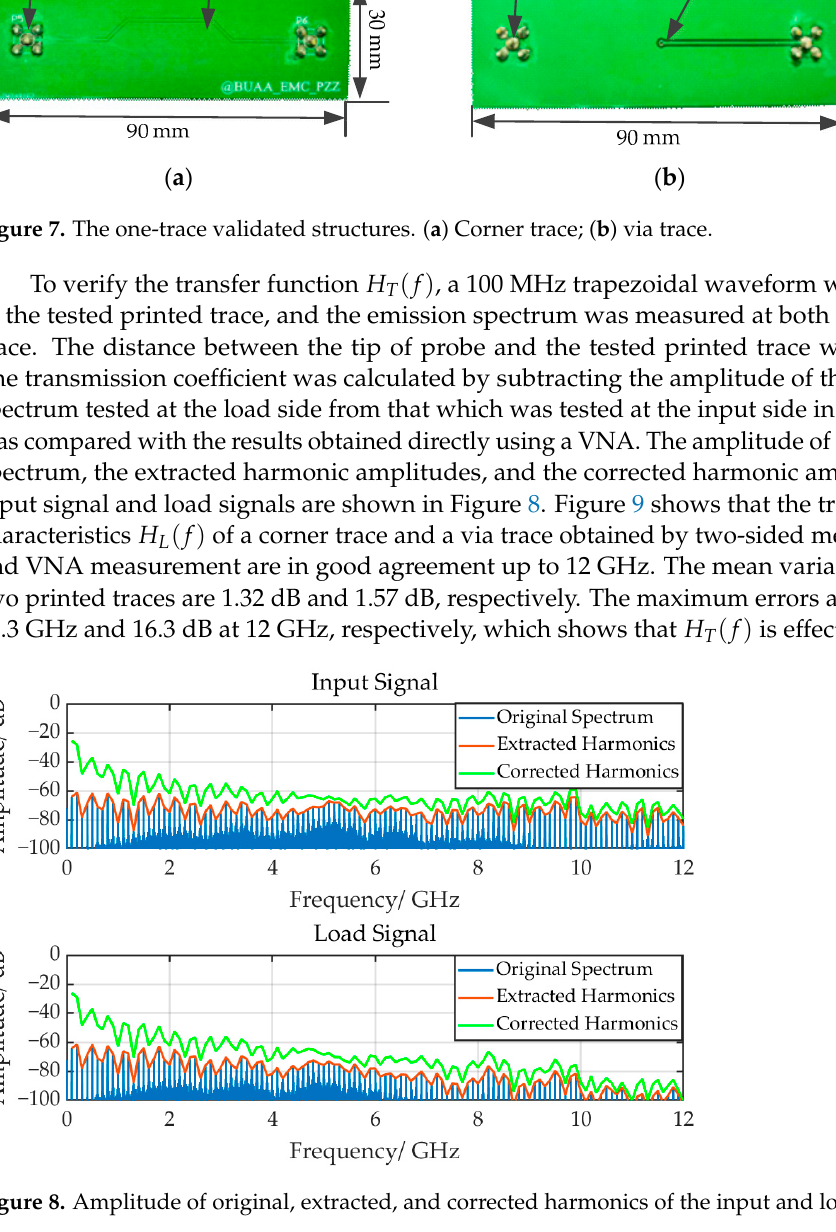
Figure 7. The one-trace validated structures. ( a ) Corner trace; ( b ) via trace.